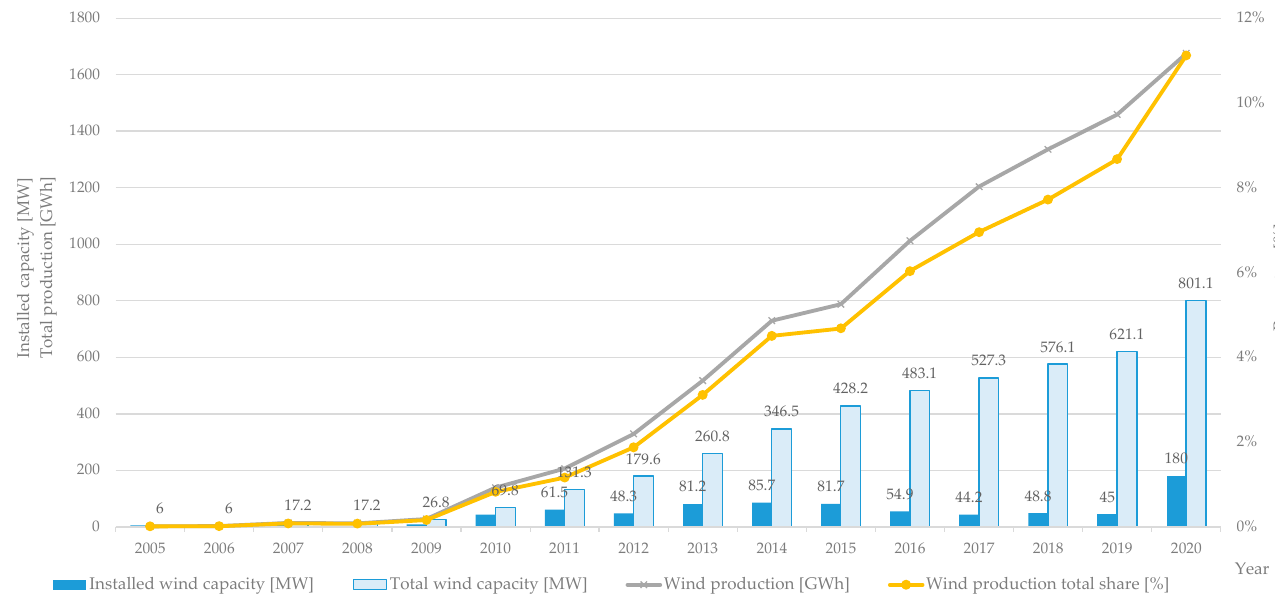
Figure 4. PV integration dominates in the Split area, while WPP integration dominates in the Rijeka